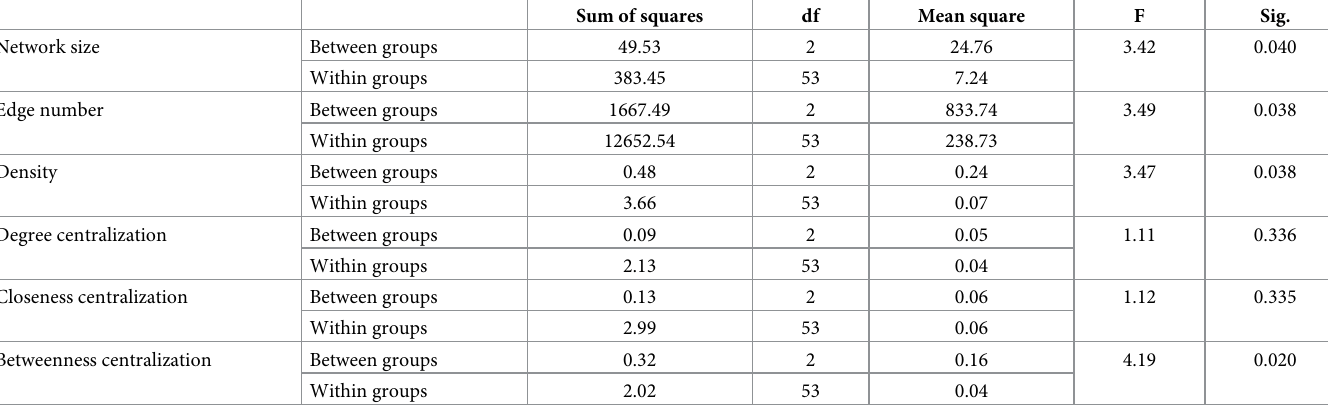
Table 3. Results from the one-way analysis of variance (ANOVA) test for the various network measures across three different project categories. Sum of squares Sig.